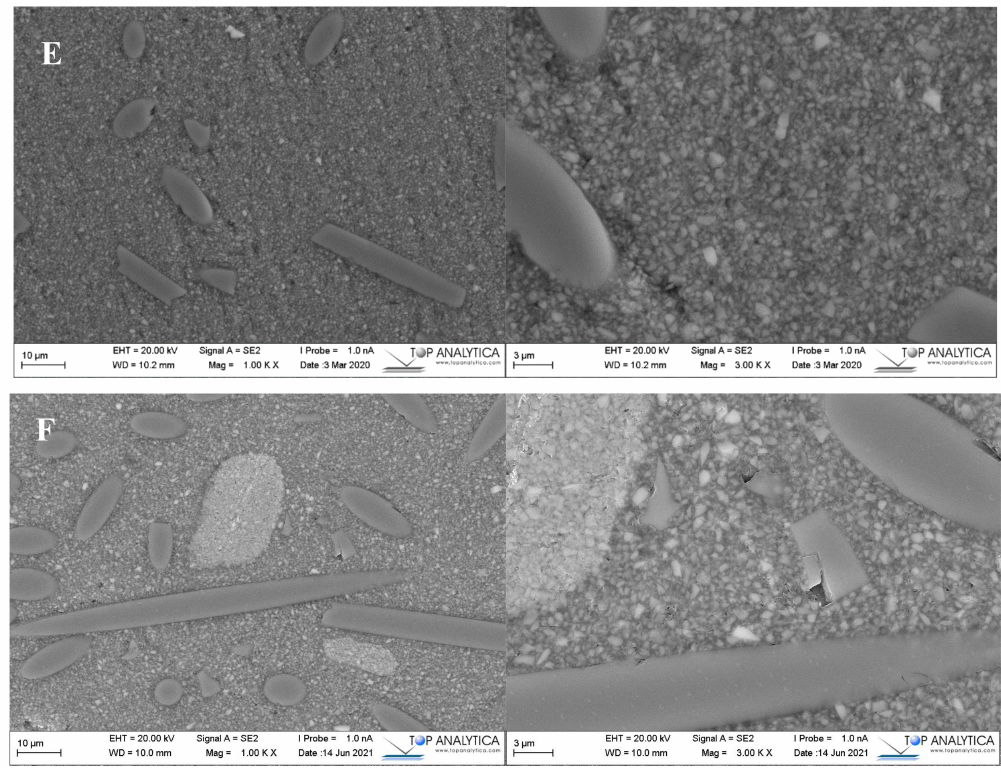
Figure 5. SEM photomicrographs (magnification: 1000 and 3000 × ) of polished surface of investigated materials (scale bar= 10 and 3 µ m). ( A ) Gradia; ( B ) Rebilda; ( C ) Luxa; ( D ) Visalys ® ; ( E ) SFRC1; ( F )